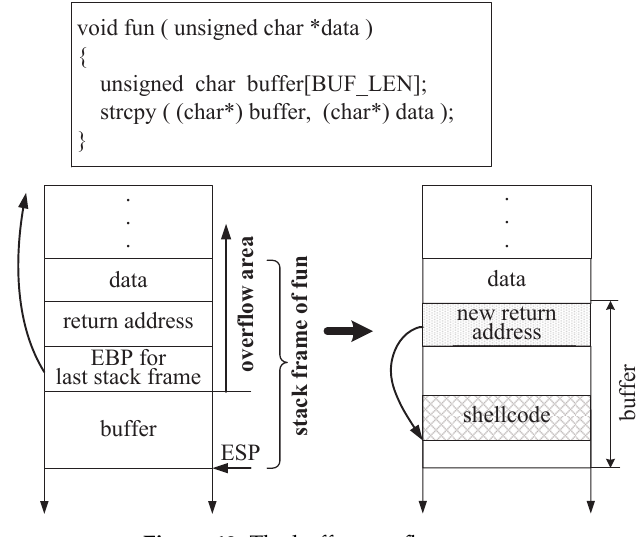
Figure 12. The buffer overflow